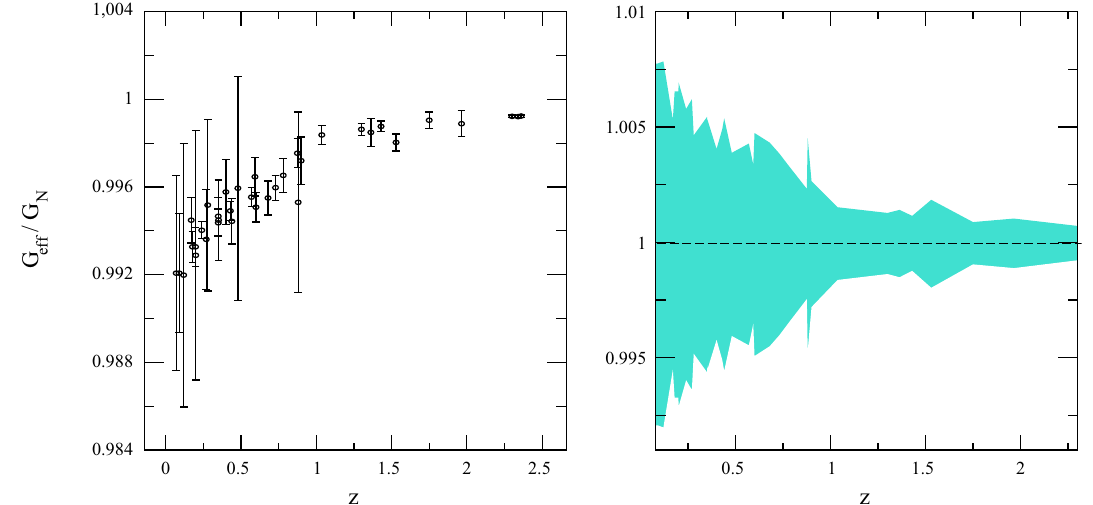
Fig. 5 Results for the f 1 CDM power-law model of (12). Left graph estimation of G eff / G N as a function of the redshift, from 37 Hubble data points. Right graph reconstruction of G eff / G N as a function of the redshift, from the observational Hubble parameter data, for b ∈ [− 0 . 01 , 0 . 01